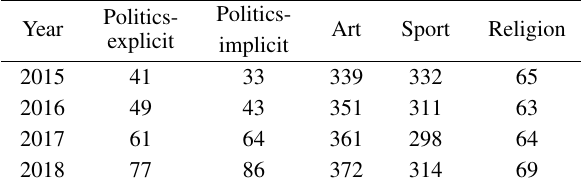
Fig. 1 Prevalence of bio keyword categories, by year–cross- sectional sample. Table 1 Prevalence of bio keywords by category and